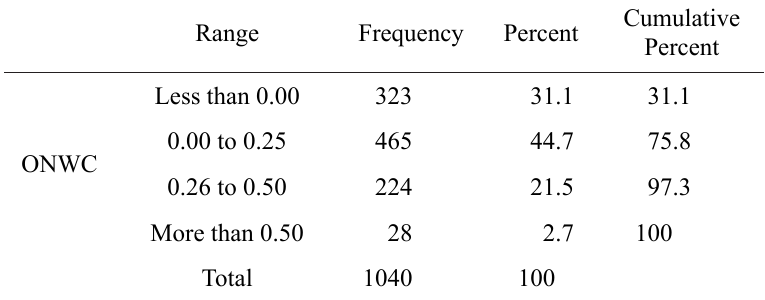
Frequency Distribution of ONWC Range Frequency Percent Less than 0.00 323 31.1 31.1 0.00 to 0.25 465 44.7 75.8 ONWC 0.26 to 0.50 224 21.5 97.3 More than 0.50 28 2.7 100 Total 1040